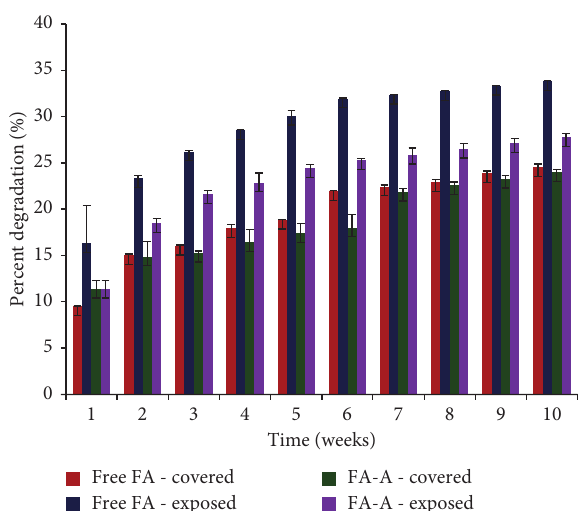
Figure 3: Percent degradation of folic acid as a result of photo effect with time (Free FA: free folic acid; FA-A: folic acid encap- sulated submicron particles).